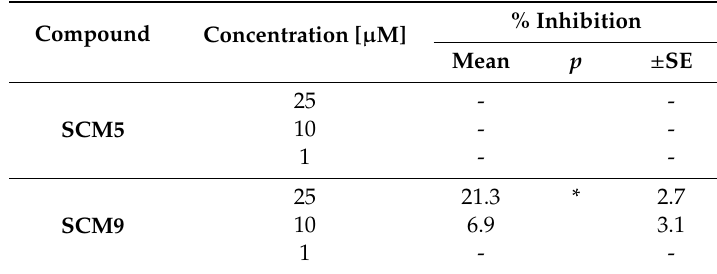
Table 4. The e ff ects of SCM compounds on TNF α production by LPS-stimulated human whole blood cultures. Human whole blood cultures were incubated overnight with the compounds at concentrations of 25, 10 and 1 µ M and 100 ng / mL of LPS. TNF α levels in the supernatants were determined by ELISA kit. The results are shown as percentage of inhibition versus DMSO control (mean values from three independent experiments ±